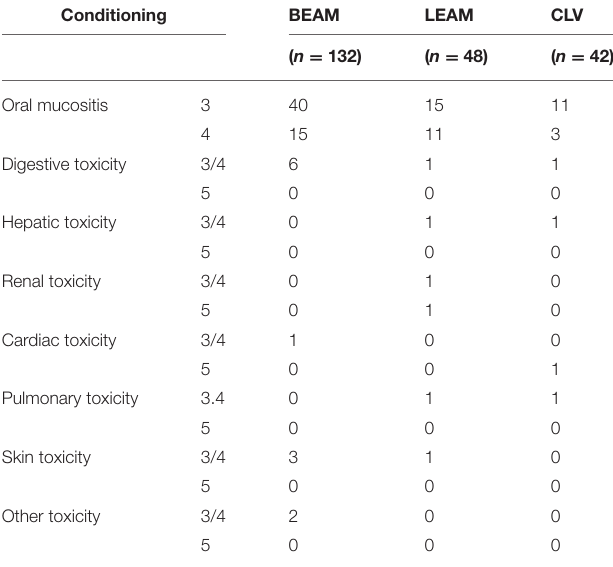
lymphohistiocytosis that led to delayed engraftment for platelets and neutrophils, until day 51, respectively, day 97 ( Figure 1 ).